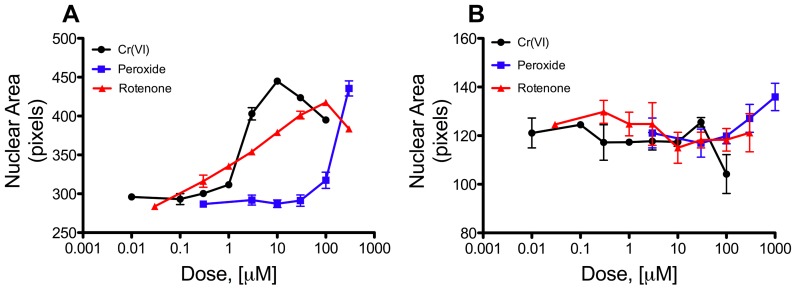
Nuclear morphology in undifferentiated and differentiated Caco-2.Nuclear area in undifferentiated (A) and differentiated (B) Caco-2. Nuclear area was measured in same cells as in Figure 1. Data shown represents two independent experiments, each in triplicate. Data are plotted as mean ± SEM of nuclear area in actual pixels. Control values are plotted at 10-fold below the lowest treatment dose.